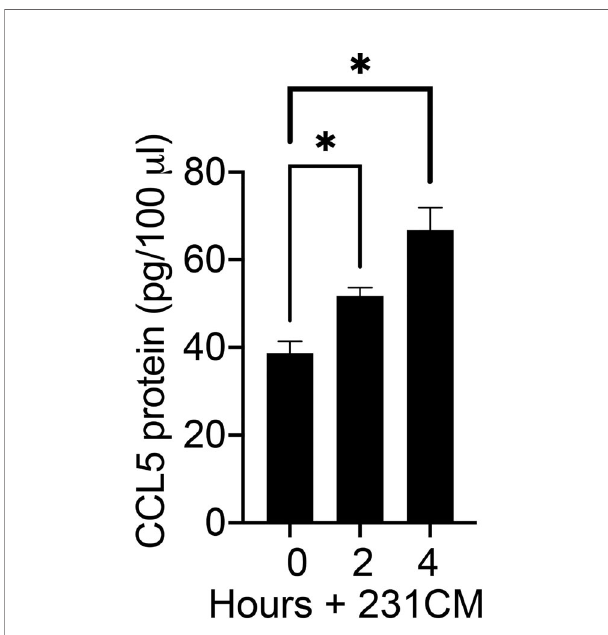
FIGURE 3 | Breast tumor cells stimulate CCL5 protein production in human mammary fi broblasts. The graph depicts results from CCL5 ELISA analysis of cell culture supernatant from HTB-125 human mammary fi broblasts exposed to 231CM compared to supernatant from fi broblasts maintained in regular growth media. Fibroblasts exposed to tumor cell-conditioned media were treated for 2 h or 4 h, after which the media was replaced growth media. 24 h later the media were collected and subjected to ELISA analysis. The data represented in graph are derived from at least three independent experiments. *p < 0.05 against control by t-test.